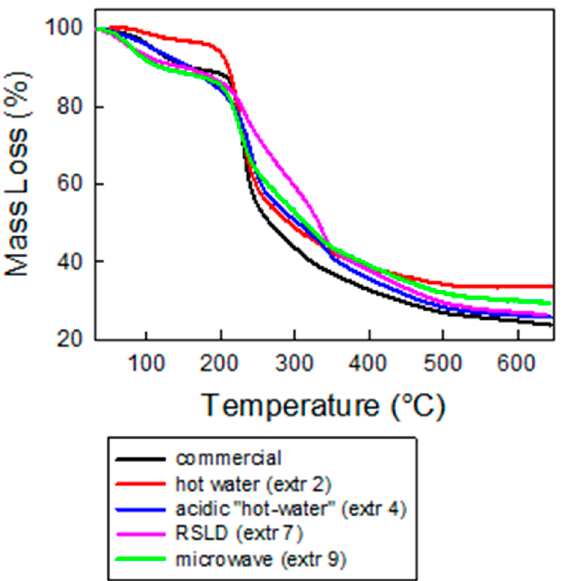
Figure 5. Thermogravimetric analysis (TGA) curves of pectin obtained through “hot-water” extraction in absence (extraction 2) of and in the presence of citric acid (Extraction 4), RSLD extraction (Extraction 7), microwave-assisted extraction (extraction 9) and commercial pectin.